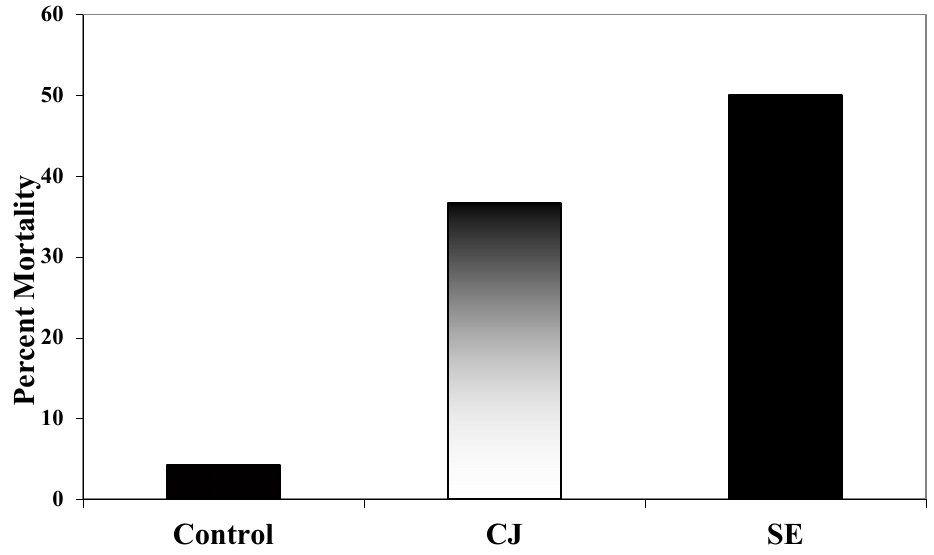
Figure 3. Chick mortality. Birds were injected intra-abdominally with 1 × 10 8 CFUs CJ; 1 × 10 3 SE and mortalities were recorded for 72 h post-injection. Total numbers of chickens used in three repetitions in mortality studies: control 220; CJ 205; SE 200. Birds that succumbed in the first 4 h post-infection were not considered CJ- or SE-associated mortalities. Birds whose condition provoked humane euthanasia were considered mortalities for all groups after the first 4 h post-infection.